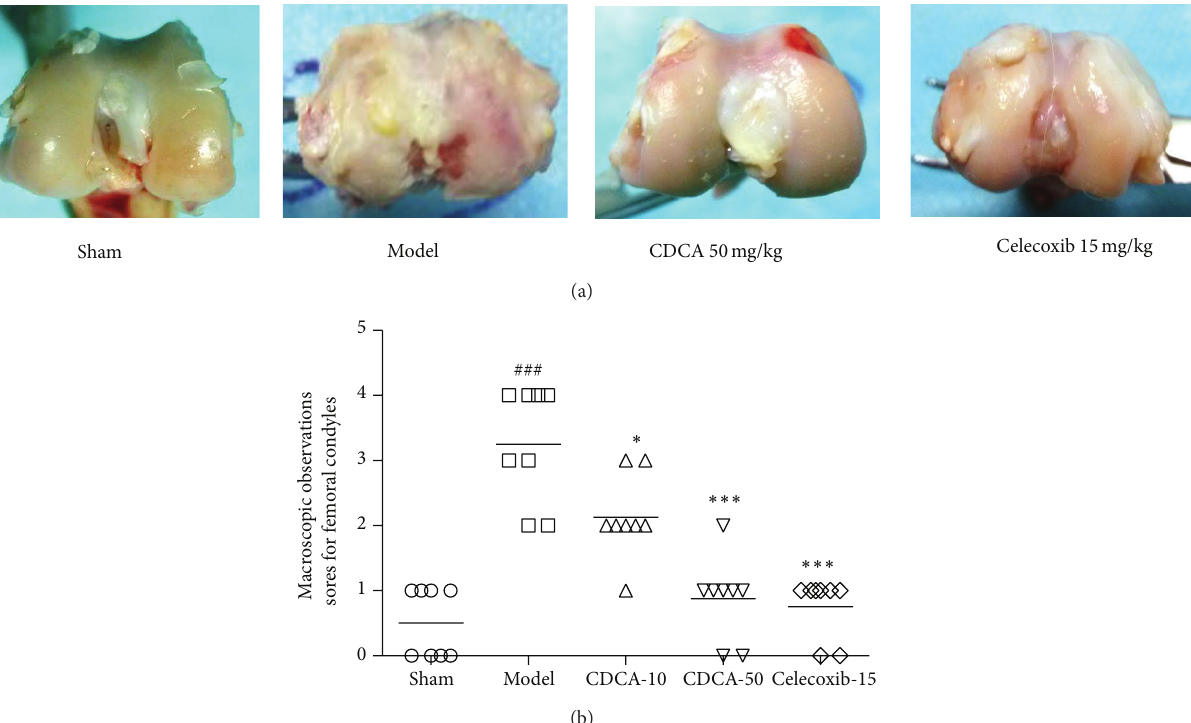
Figure 1: (a) Representative macroscopic observations images of femoral condyles are shown. (b) Macroscopic observations sores for femoral condyles in the five groups of experimental rabbits. Results are presented as individual data points and the median for each group is indicated by a horizontal bar. ### 𝑃 < 0.001 , compared with the sham-operation group; ∗ 𝑃 < 0.05 , ∗∗∗ 𝑃 < 0.001 , compared with the model group. Similar results were observed in two separated